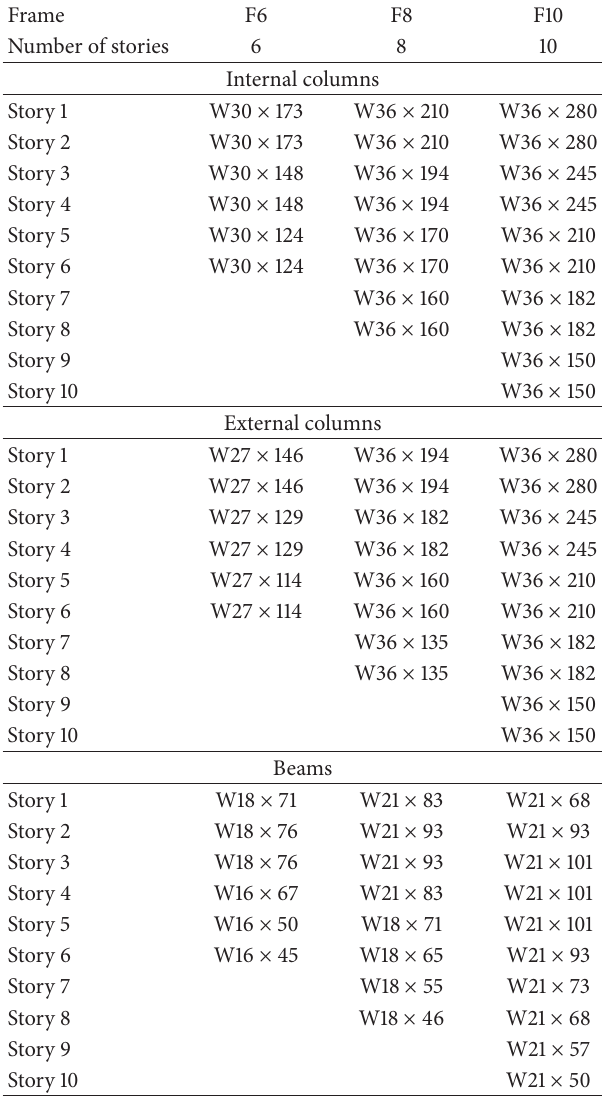
Table 1: Relevant characteristics of the steel